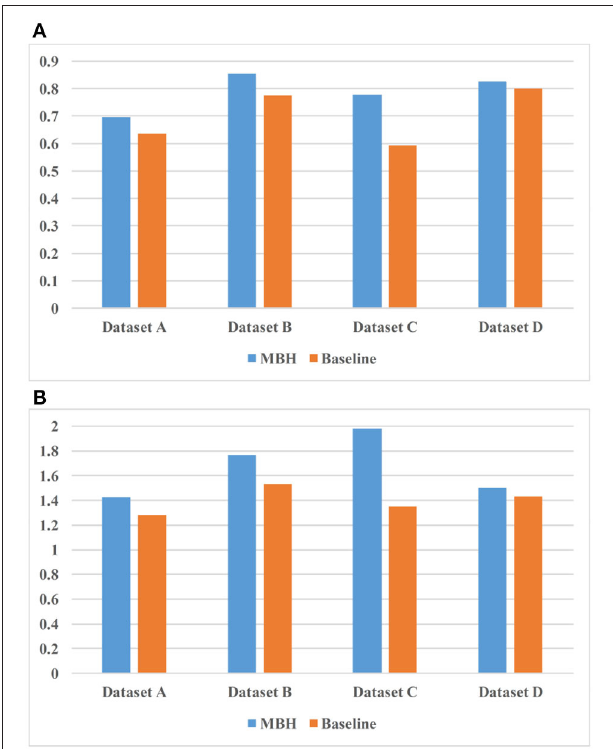
FIGURE 8 | Comparison result of MBH (method based on annotated HIN) and baseline. (A) uses nDCG as the evaluation criterion and (B) uses HL as the evaluation criterion.